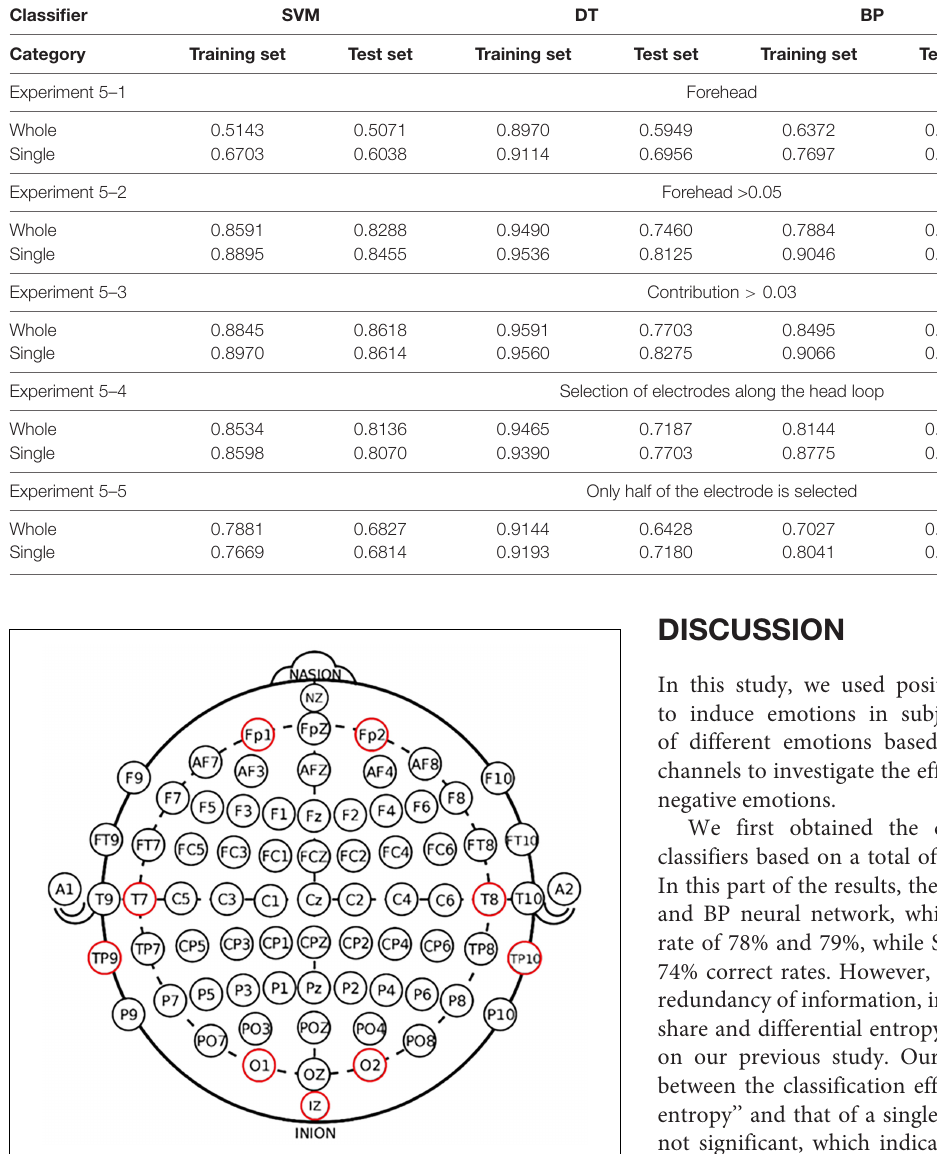
combination is the energy proportion and differential entropy of the δ , θ , α , β , and γ bands of the two channels, with a total of 20-dimensional features. The best results are shown in Table 8